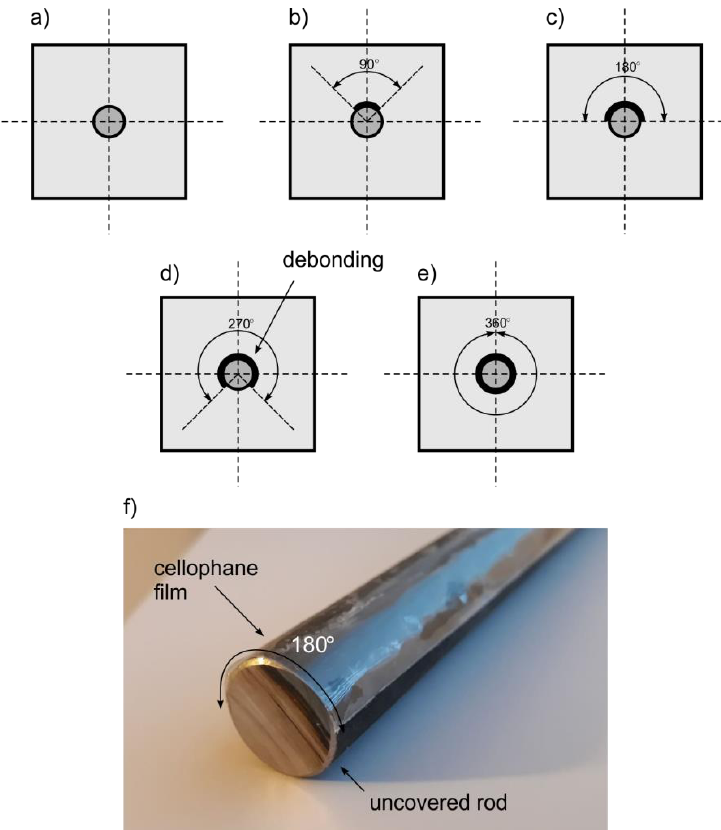
Figure 5. Schemes of investigated specimens: ( a ) beam #A with healthy bonded rod and beams with circumferential debonding with extent of ( b ) #B = 90, ( c ) #C = 180, ( d ) #D = 270, ( e ) #E = 360, and ( f ) a photograph of the rod wrapped in cellophane film.